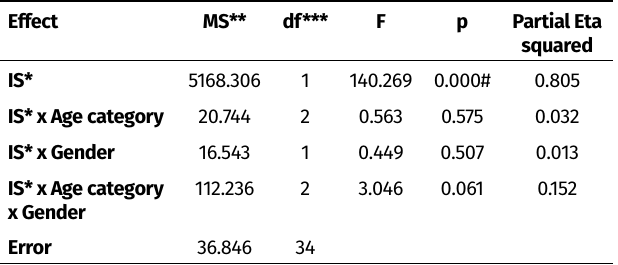
Table 3. Repeated Measures ANOVA Test of Within-Subjects Effects for Heart Rate in the PTTF-test.